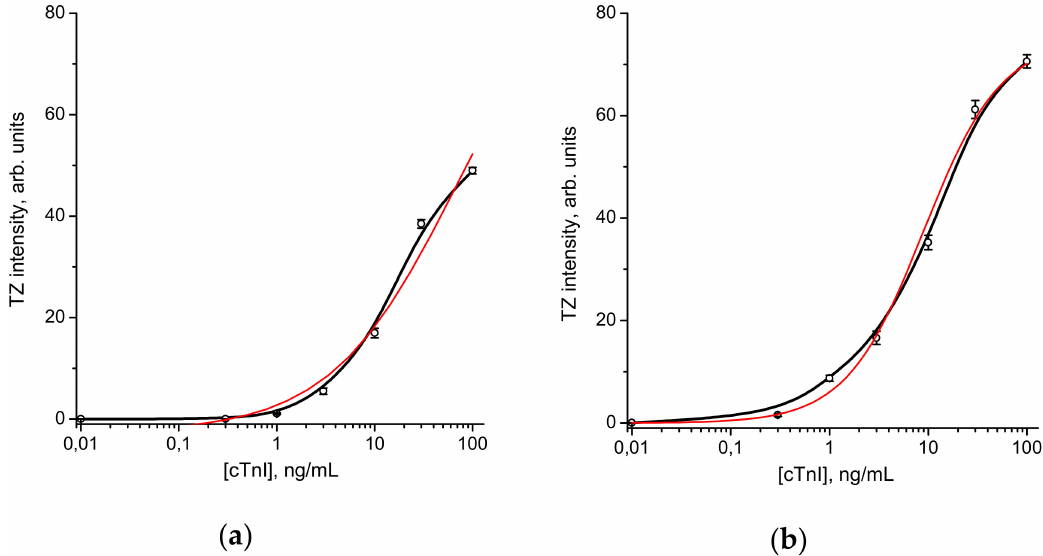
Figure 4. Dependence of the intensity of TZ staining on the concentration of cTnI in the sample was approximated (red line) by the function: y = ( A − D ) / (1 + ( x / C ) B ) + D . For the conjugate C-GNPs-3 (33.7 nm)–IC4 with adsorption immobilization of antibodies ( a ) A = 0.07, D = 49.15, C = 23.0, and B = 2.62; for the conjugate sGNPs-4 (64.5 nm)–IC4 with covalent immobilization of antibodies ( b ), A = 0.04, D = 75.0, C = 8.98, and B = 1.11. All measurements were performed in